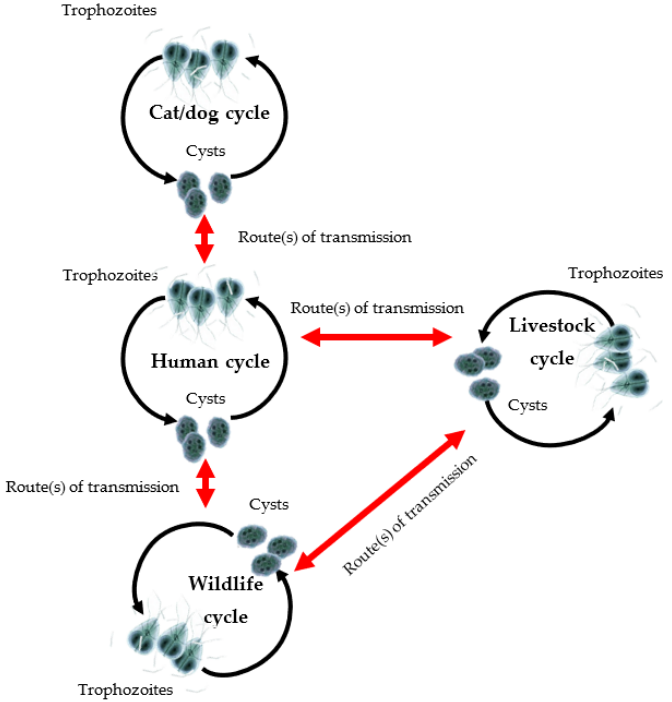
Figure 1. Cycles of transmission of G. duodenalis in mammalian hosts. Some assemblages, such as assemblage A, have low host specificity and are capable of infecting humans as well as other animals (modified from Monis et al., 2009).